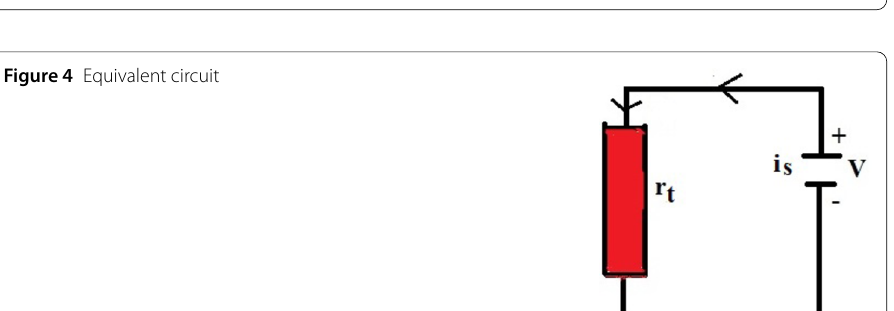
Figure 3 Parallel circuit with p resistances